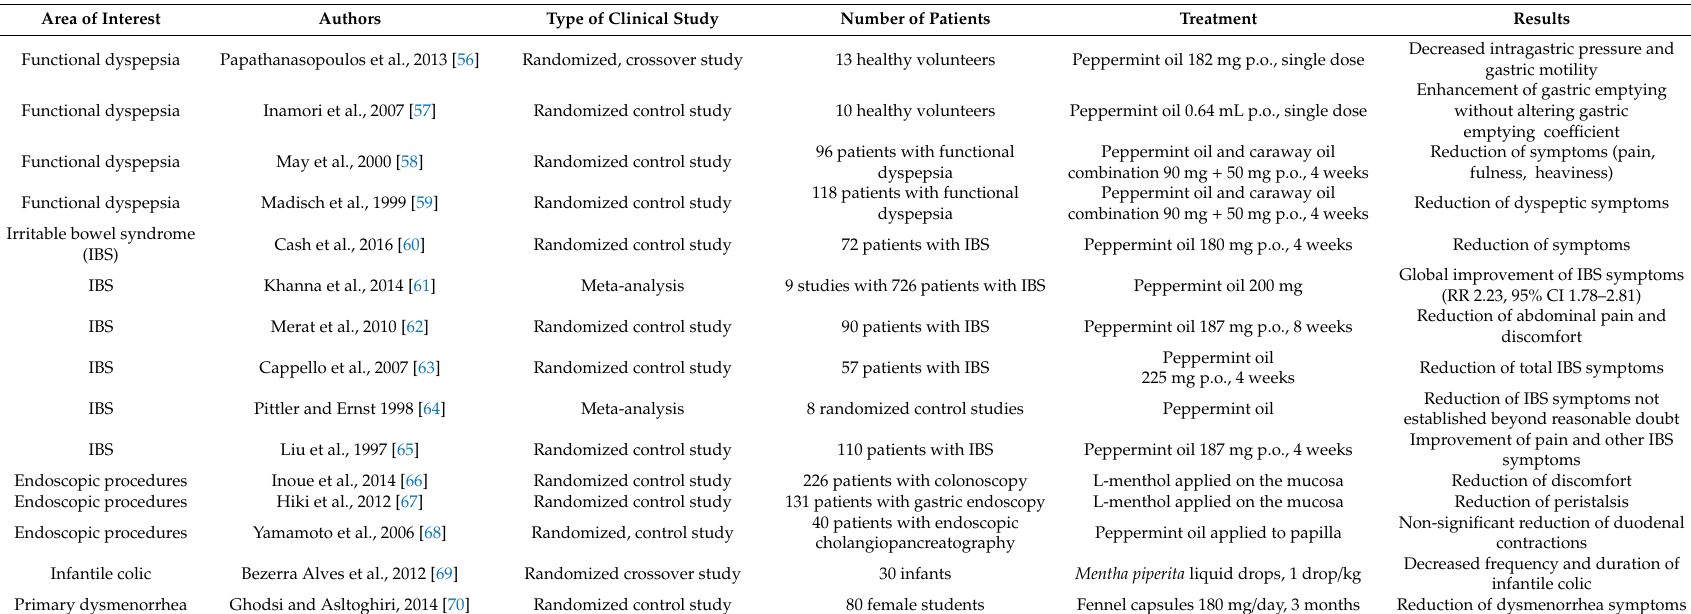
Table 2. Clinical studies evaluating antispasmodic potential of essential